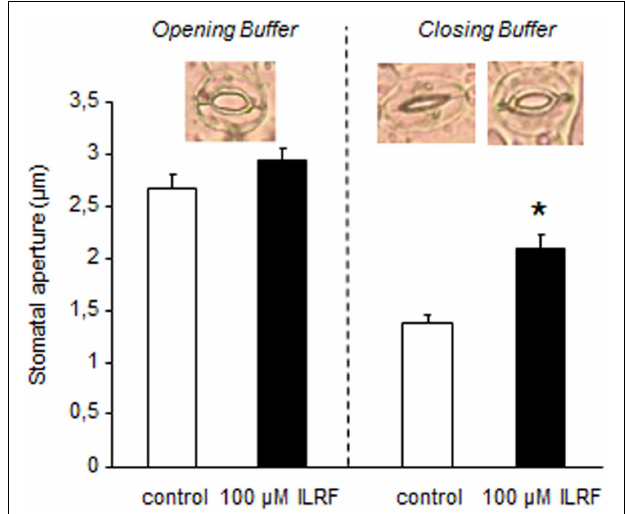
FIGURE 4 | Changes in Arabidopsis stomatal apertures of epidermal strips maintained in opening buffer or closing buffer upon treatment with 100 µ M ILRF . Means ± SE ( n = 65–75 stomata for each treatment). *Significant difference ( P < 0.05) in stomatal aperture when compared to the control was found after treatment with ILRF in closing buffer, but not opening